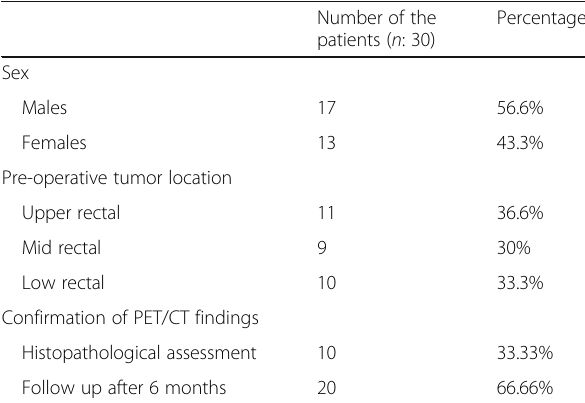
Table 1 Distribution of the studied patients according to different parameters